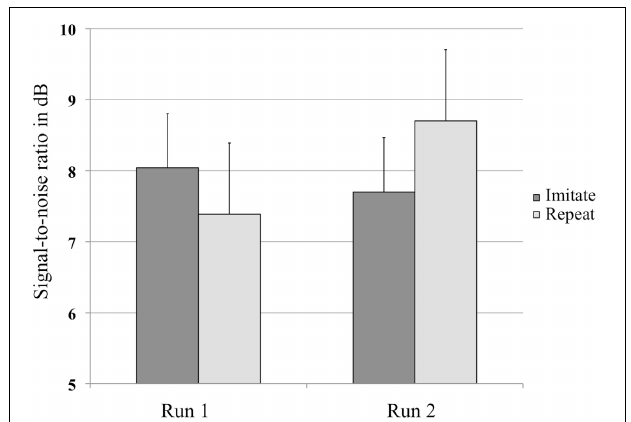
FIGURE 2 | Average values in decibel (dB) at which the sentences were presented in the experiment for both groups, before and after training. Error bars represent one standard